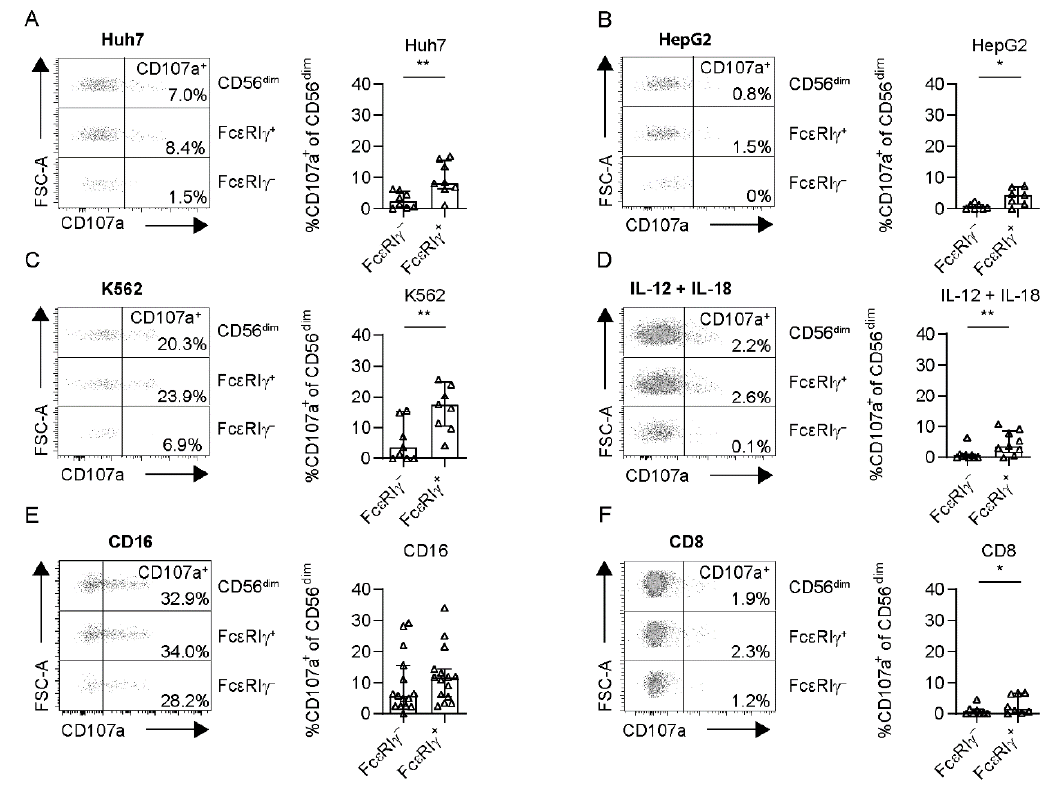
Figure 3. Functional capacity of adaptive versus conventional NK cells in HCC patients. CD107a expression of CD56 dim NK cells following stimulation with Huh7 ( A ) ( n = 8), HepG2 ( B ) ( n = 7) or K562 ( C ), n = 9) cell lines for 5 h, cytokine stimulation with IL-12 and IL-18 overnight ( D ) ( n = 9) CD16 crosslink ( E ) ( n = 8), or stimulation with activated autologous CD8 + T cells for 5 h ( F ) ( n = 8) in HCMV + HCC patients. Each dot represents an HCMV + individual. Bars indicate median with IQR. Patients with less than 10% adaptive Fc ε RI γ − CD56 dim NK cells were excluded. The following statistical analyses were performed: two-tailed Wilcoxon Test. *: p < 0.05; **: p < 0.01.